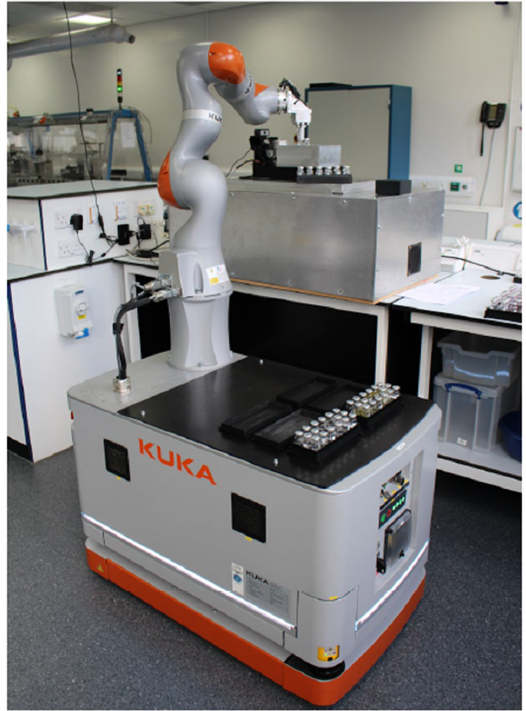
Figure 10. Chemist robot at laboratory scale used for the synthesis of photocatalysts to produce green H 2